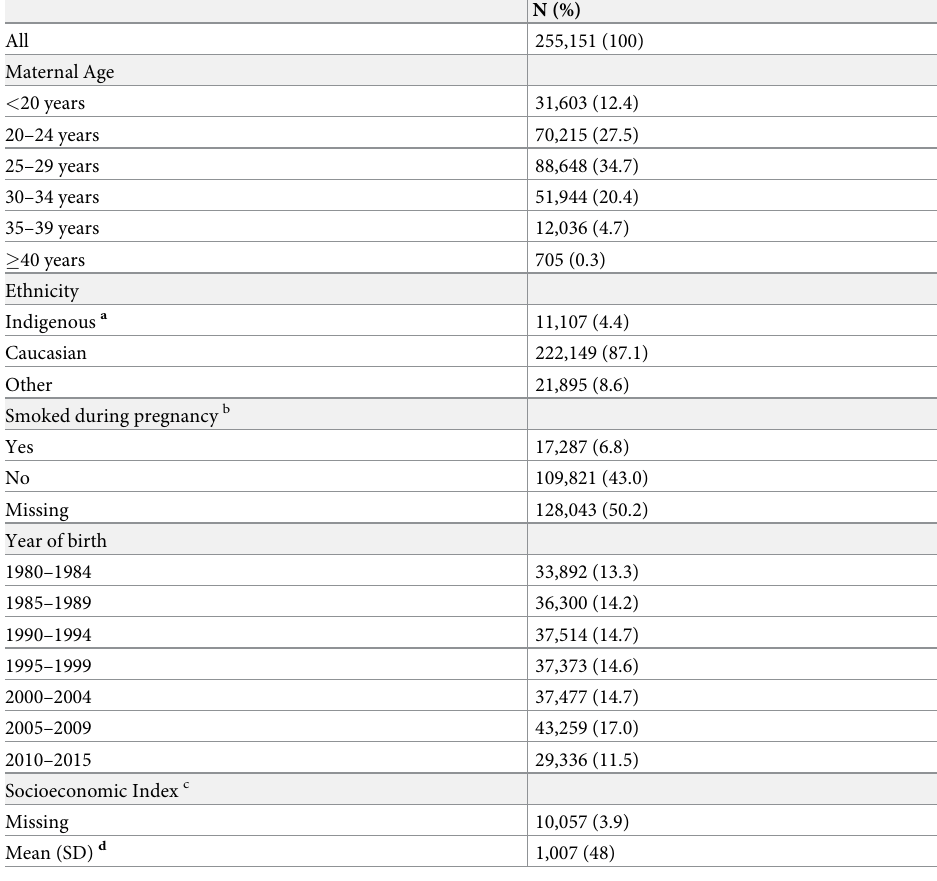
Table 1. Characteristics of the study population of mothers who gave birth to their first two singleton children between 1980 and 2015 in Western Australia (N = 255,151 mothers). N (%) All 255,151